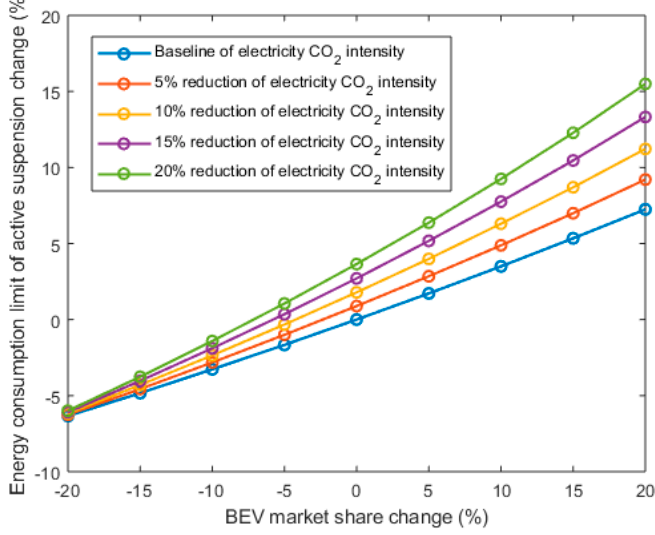
Figure 8. The sensitivity of the 1.5 °C target active suspension energy consumption limit to technology penetration.